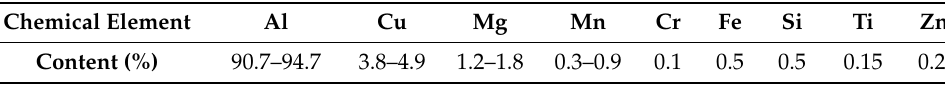
Table 1. Chemical composition of Al 2024-O.